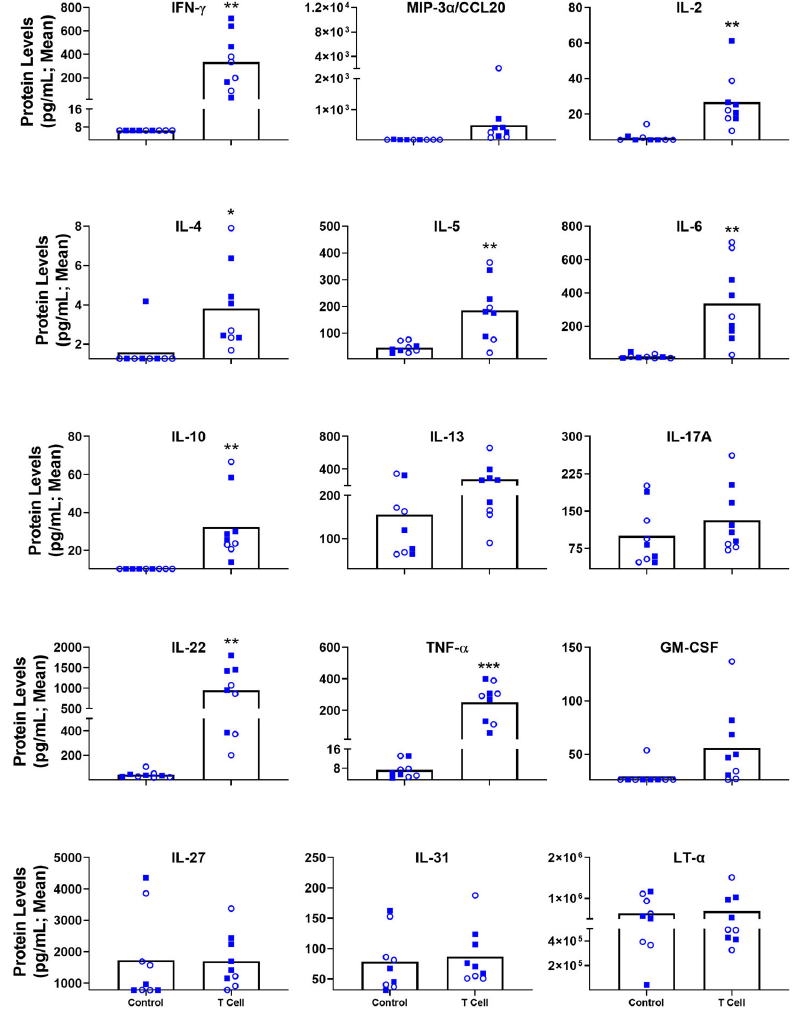
Figure 5. Individual inflammatory markers dysregulated within chronic, T cell transfer colitis model at Day 35 post-T cell transfer. Rag KO mice (n = 10/group) were injected i.p. with proinflammatory (CD4+ CD25 LOW CD45RB HIGH isolated from spleens of C57BL/6 mice. Serum was collected on Day 35 and used for a multiplexed cytokine/chemokine analysis. Raw concentration values were determined through use of a standard curve using the Milliplex TM Analyst software and plotted. Grouped data is presented as mean + standard error of mean (SEM). Circles (empty) and squares (filled) represent Rag1 ‐ / ‐ and Rag2 ‐ / ‐ mice, respectively. Statistical significance of differences is compared relative to the control group and is shown as *: p < 0.05, **: p < 0.01 & ***: p < 0.001 by two ‐ tailed unpaired parametric t ‐ tests with the Welch’s correction.